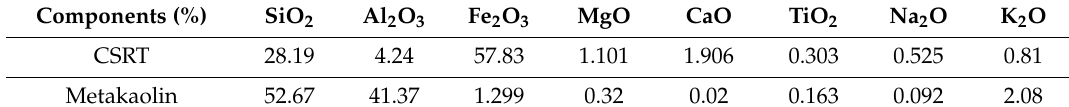
Table 1. Chemical composition of the, copper slag reprocessing tailings (CSRT) and metakaolin. Components (%)